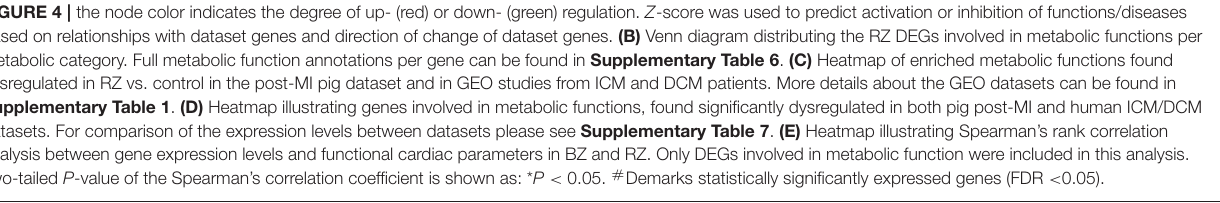
FIGURE 4 | the node color indicates the degree of up- (red) or down- (green) regulation. Z -score was used to predict activation or inhibition of functions/diseases based on relationships with dataset genes and direction of change of dataset genes. (B) Venn diagram distributing the RZ DEGs involved in metabolic functions per